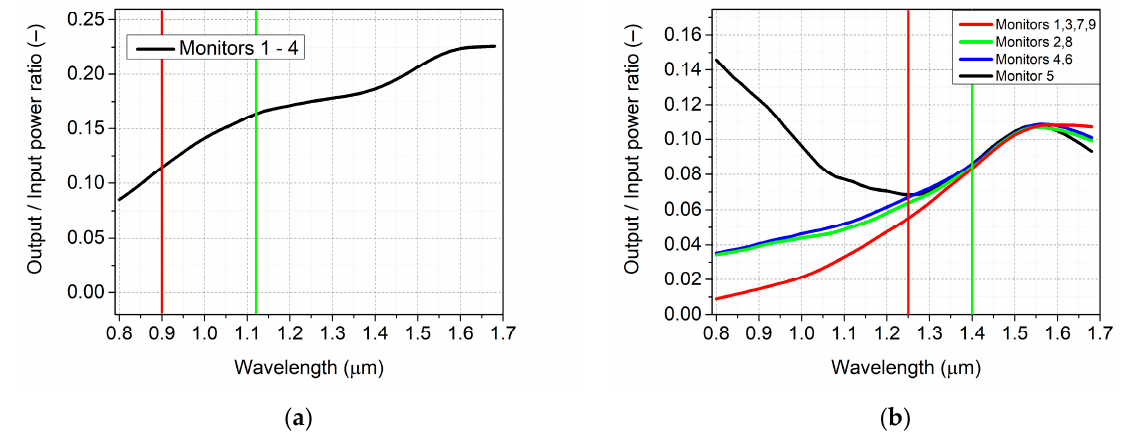
Figure 6. Spectral characteristics as simulated by BPM, red lines signify − 3 dB loss against the maximum output value, and green line signifies the point where output maxima retain correct distribution and sufficient separation: ( a ) 1 × 4 splitter; ( b ) 1 × 9 splitter.